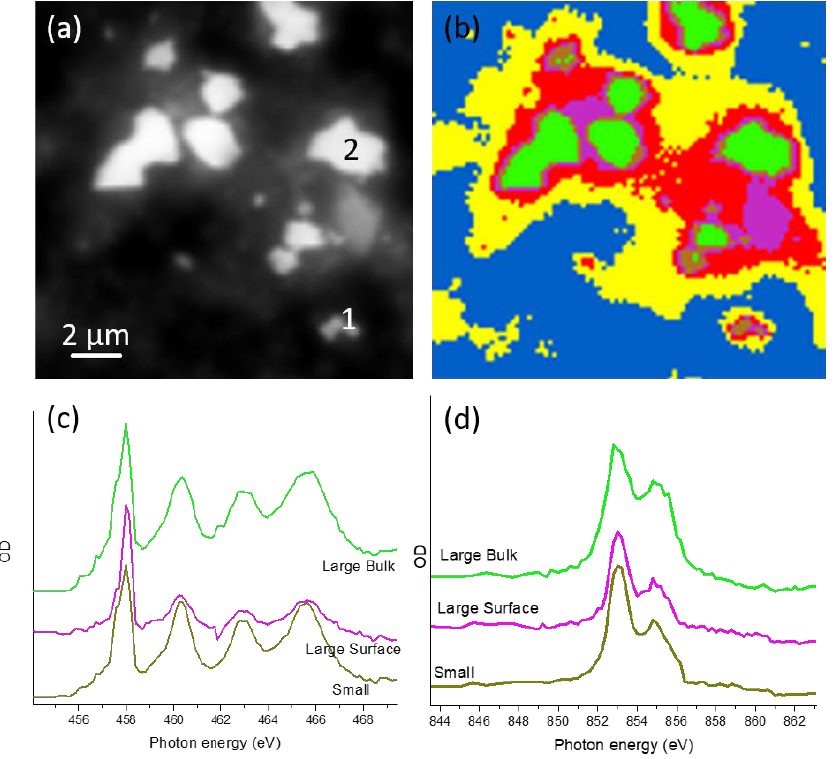
Figure 5. ( a ) Morphology mapping of LiMn 1.4 Ni 0.5 Ti 0.1 O 4 particles, ( b ) components distribution mapping through principal component analysis (PCA), ( c ) Ti L3 XANES and ( d ) Ni L3 XANES of major components as shown in ( b ) (same color code is applied in ( b – d )).